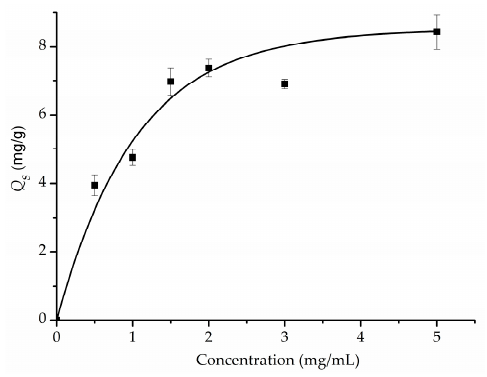
Figure 3. Effect of concentration of dopamine on specific absorption capacity ( Q s ).